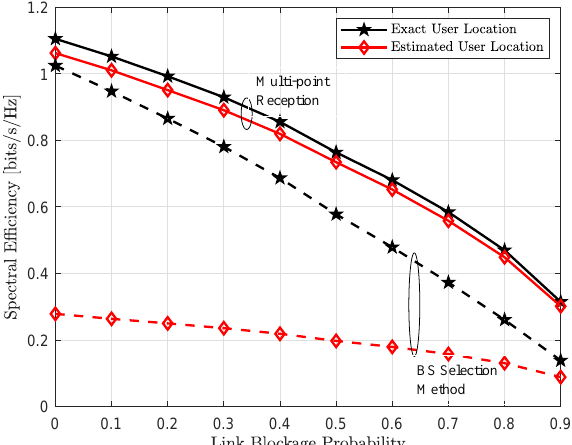
Figure 9. Achievable spectral efficiency with as a function of increasing uplink transmit power P t with the link blocking probability P b = 0.4 for multi-point reception (solid line) and BS selection method (dashed line).